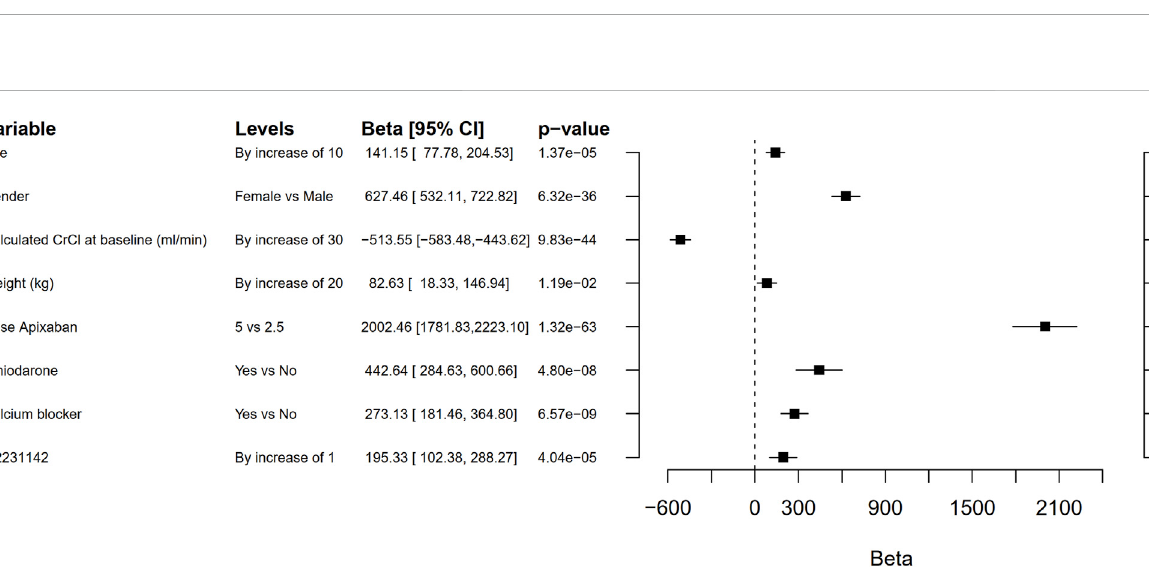
FIGURE 3 Forestplotcomparingtheeffectonareaunderthecurve(AUC)ofrs2231142withthatofage,gender,creatinineclearance(CrCL),weight,dose, co-medicationwithamiodaroneorcalciumblockers.Thebetacoef fi cientisthedegreeofchangeintheoutcomevariableforeveryunitofchangein thepredictor variable.Notethat these results are notadjusted bygenetic principal components 1to 6. The Bonferroni threshold for signi fi cance was p <